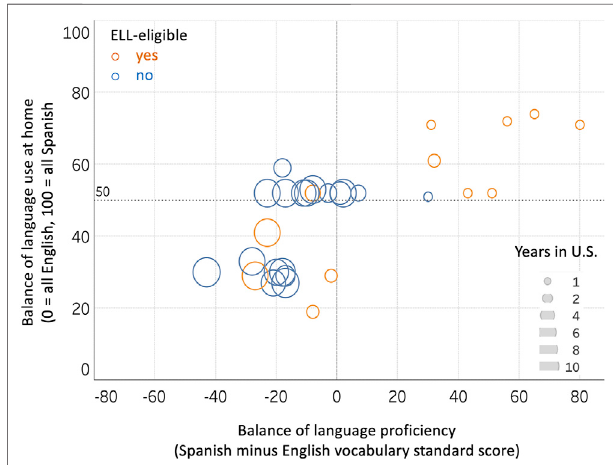
FIGURE 2 | Scatterplot showing difference scores on the x -axis, displaying the relative balance of pro fi ciency in each language in L1 Spanish speakers (Spanish minus English standardized vocabulary scores), with zero indicating balance of pro fi ciency, positive numbers indicating relative Spanish pro fi ciency dominance, and negative numbers English pro fi ciency dominance. The y -axis displays the child ’ s language usage at home in percentage of daily use, with 50% indicating balance of language use. Marker colors indicate eligibility for English learner services, and the marker size indicates the number of years the participant has lived in the United